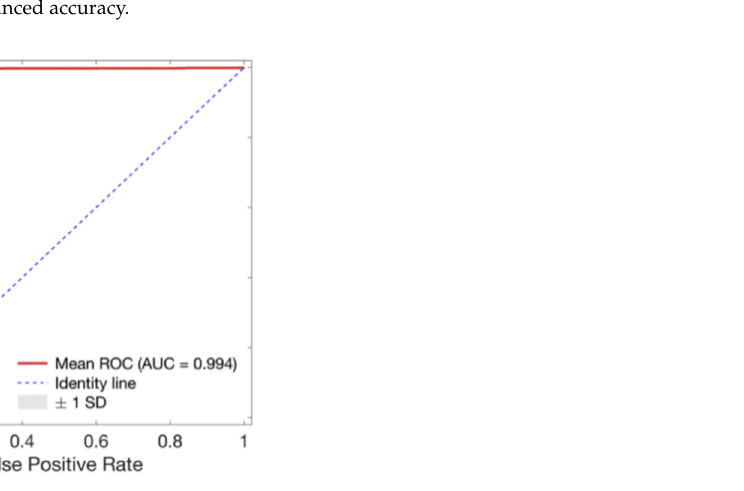
Figure 5. Receiver operating characteristic (ROC) curve for the proposed signal quality assessment model. Red line and gray area indicate mean ROC curves and ±1 standard deviation (SD) of ROC curves of every fold, respectively.